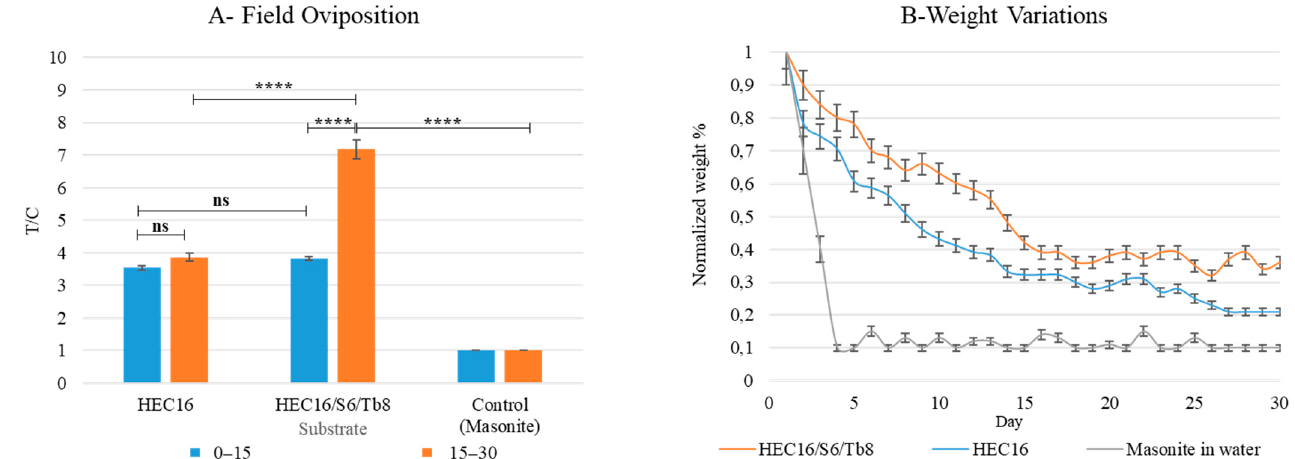
Figure 5. ( A ) Oviposition within 30 days using cardboard commercial trap (Easy trap by Gea srl), ( B ) Water evaporation in field conditions monitored through weight variation. Control is a standard ovitrap (masonite in distilled water in a black jar). T/C = eggs on sample (T)/eggs on control (C). Environmental conditions were 23 ± 1 °C, 75% RH (data from Fondazione Osservatorio Meterologico Milano Duomo). All the samples have pH = 6.5 and salinity < 1%. Statistical analysis legend: p > 0.0123 = not significant (ns); p < 0.0001 = ****.